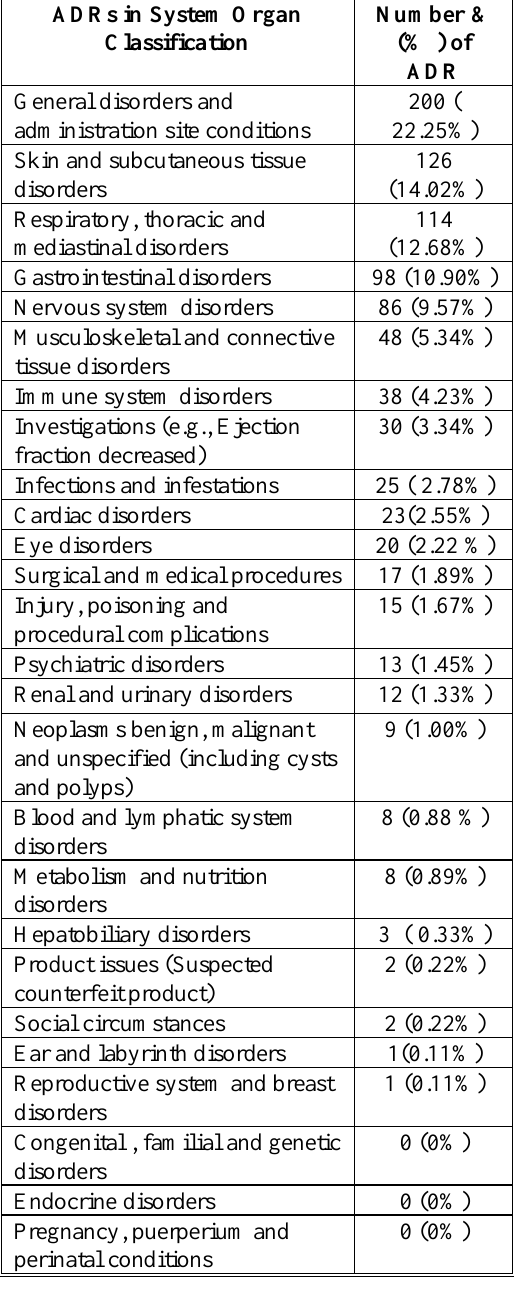
Table 3. Age group, gender, and reporter qualification distribution of ICSRs.”